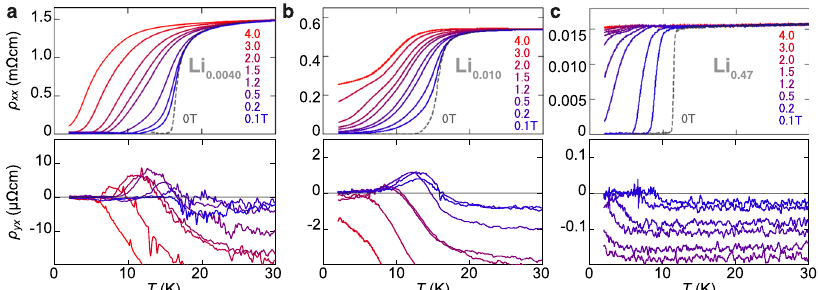
Fig. 2 | Transport properties at different doping levels x . Temperature depen- dence of longitudinal ρ xx (top) and transverse ρ yx (bottom) resistivity at varying out-of-plane fi elds for x =0.0040 a , x =0.010 b , and x =0.47 c . The vortex